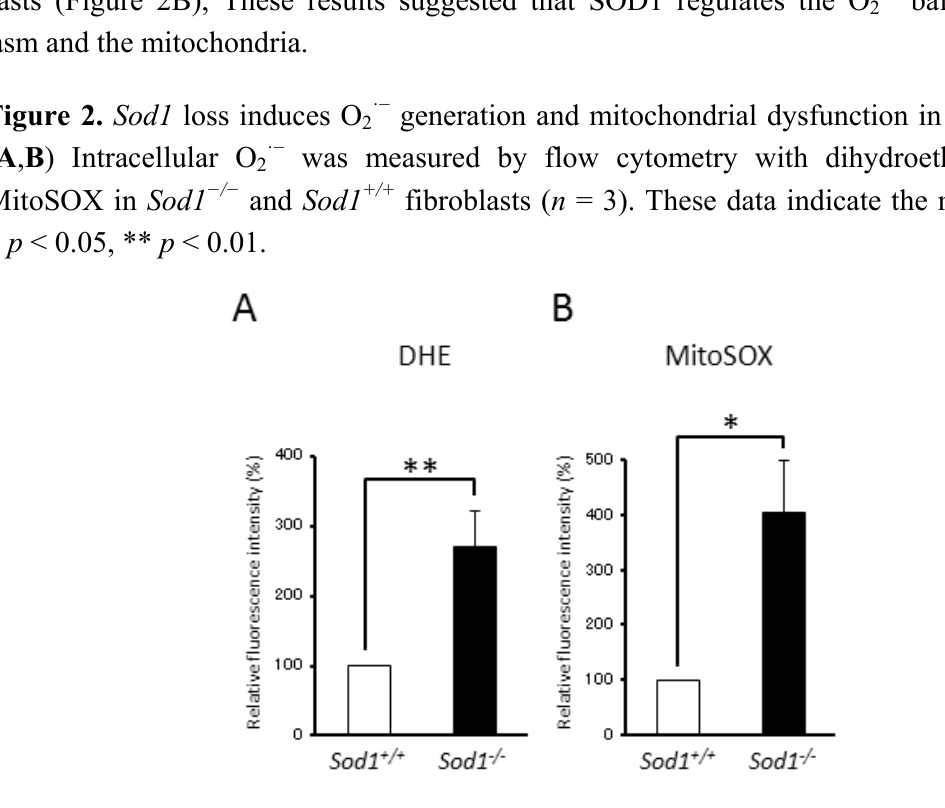
Figure 2. Sod1 loss induces O 2· − generation and mitochondrial dysfunction in